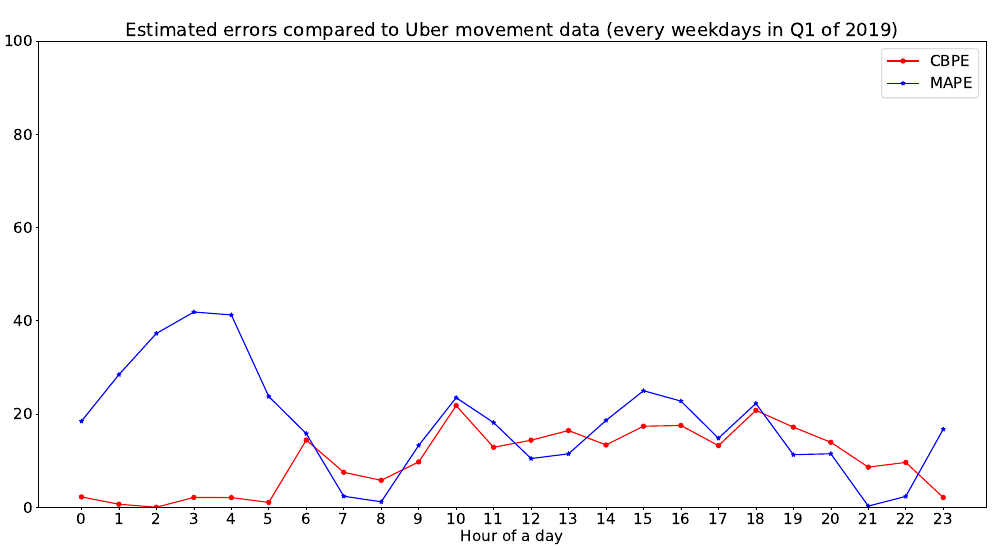
Figure 14. Estimated vs. Uber travel time comparison at 9 AM.